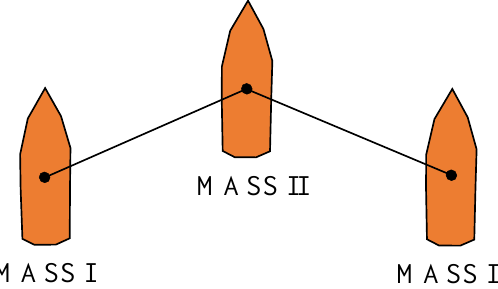
Figure 6. Swarm of MASSs communication topology.